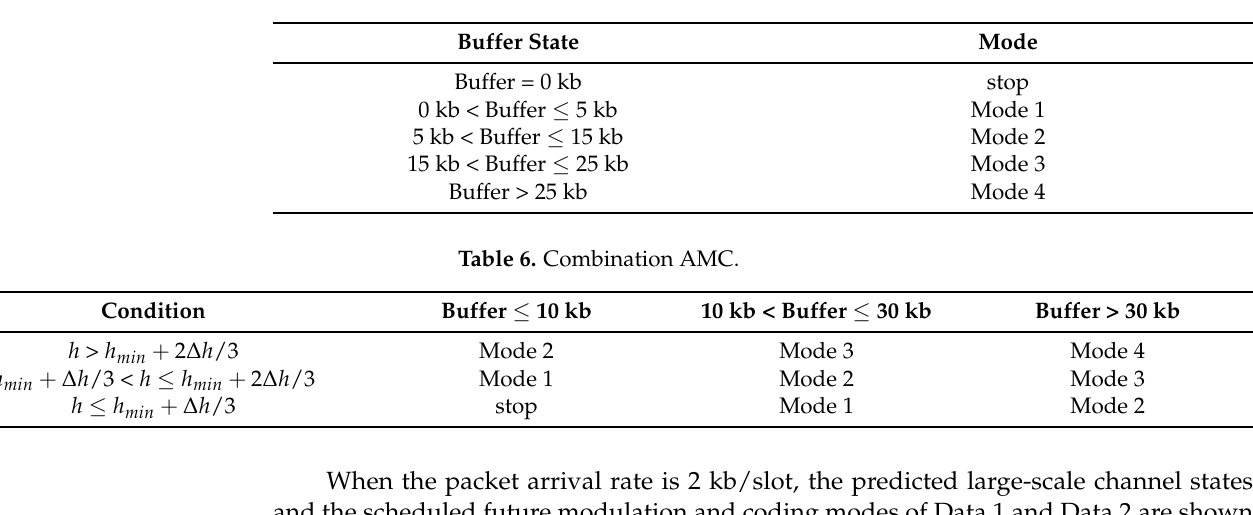
Table 5. Buffer-based AMC.